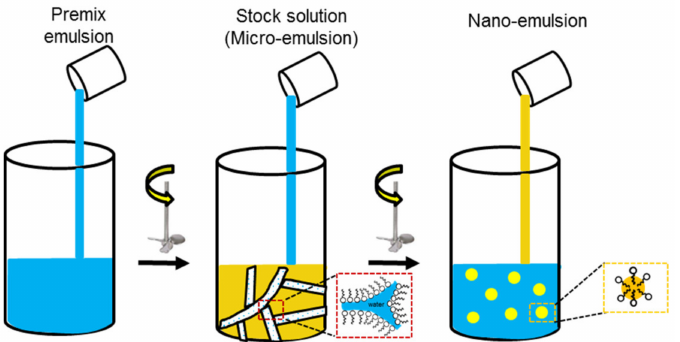
Figure 3. Schematic diagram of the process of preparing nanoemulsions by microemulsion dilution